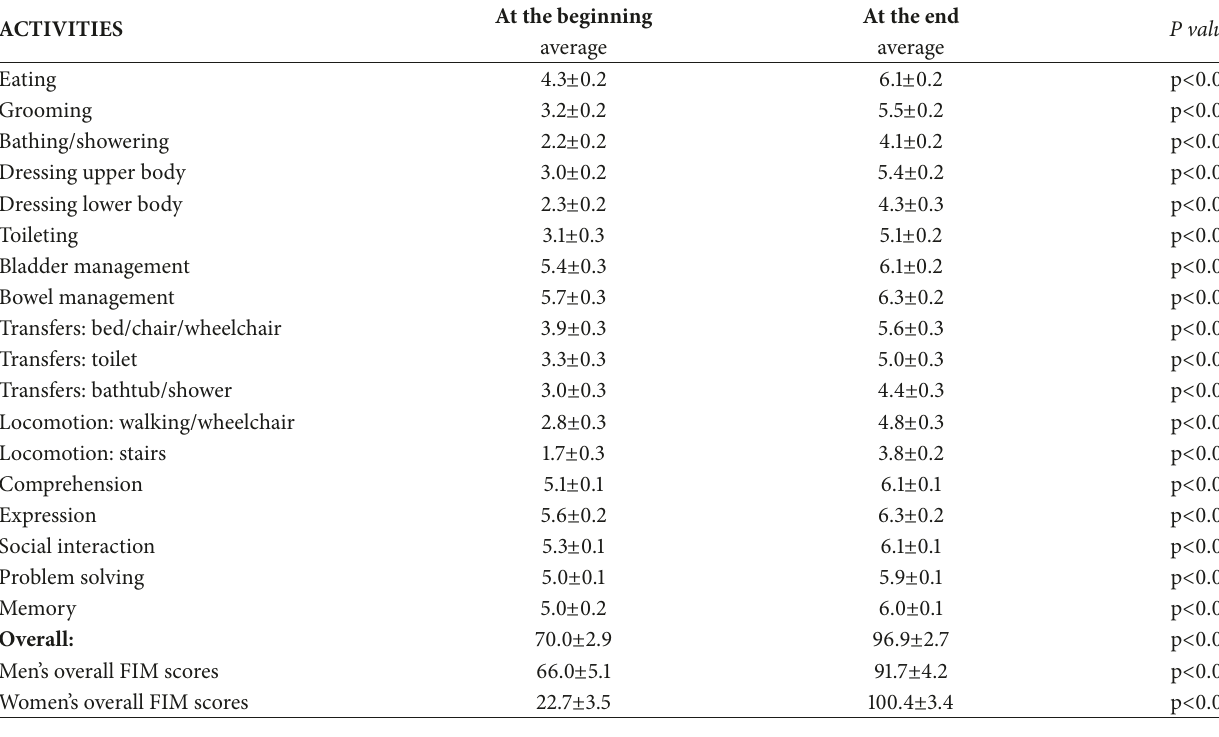
Table 3: Average FIM scores at the beginning and at the end of rehabilitation.